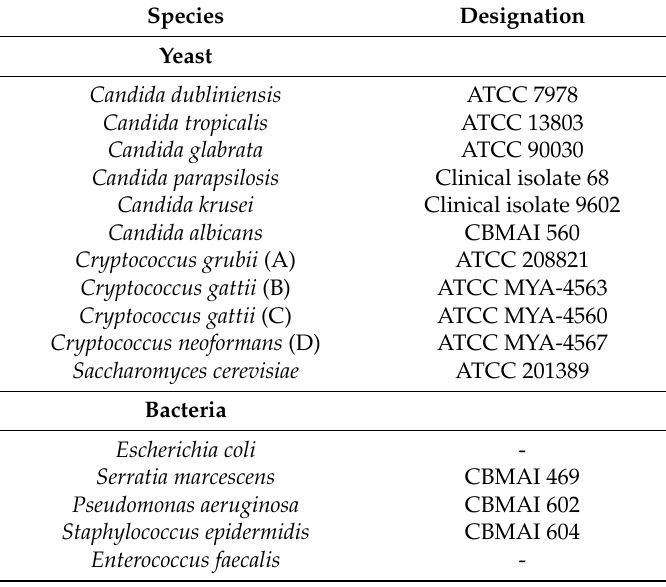
Table 1. Target strains used for antimicrobial activity